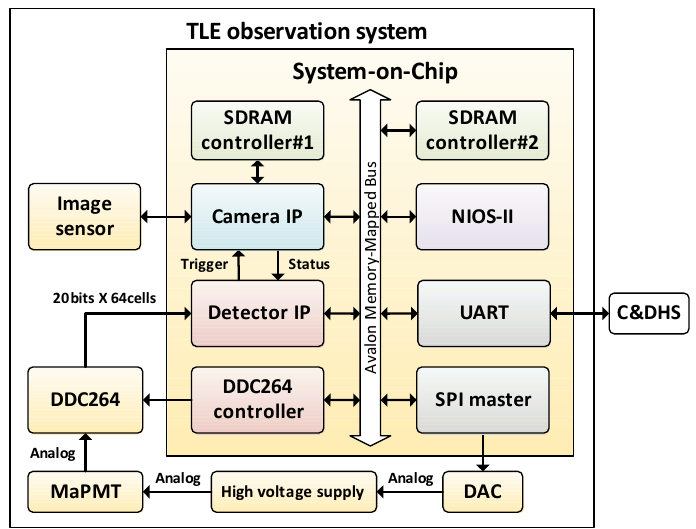
Figure 9. Data flow diagram of TLE observation system. Hardware IPs on the SoC interacts each other via Avalon Memory-Mapped Bus. Embedded software is implemented on the Nios-II to manipulate the mission data from low-level hardware